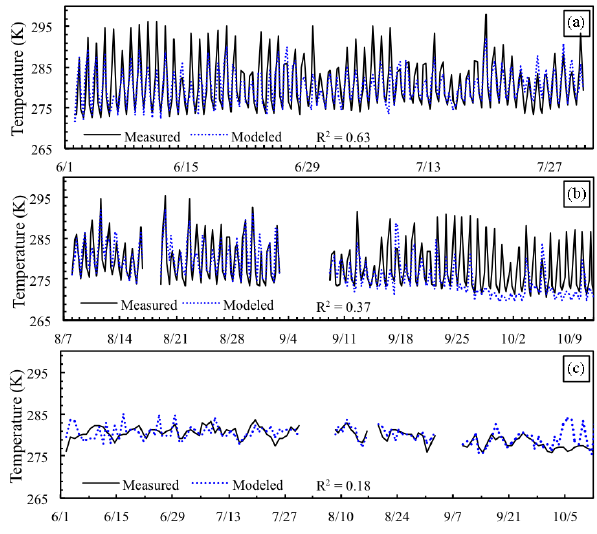
Figure 8. Modeled and measured surface temperature at Site 11 over the (a) calibration period and (a) validation period using 6h data, and (a) entire period using daily